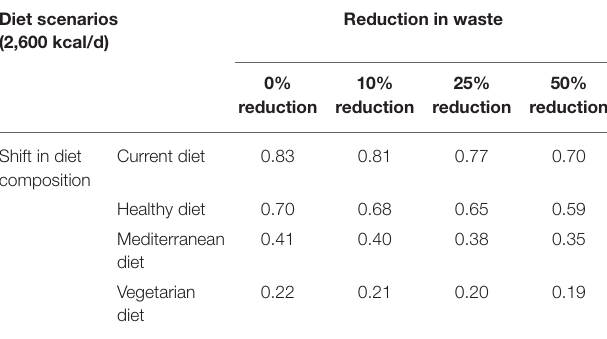
TABLE 3 | Land area (ha) required per person to support the current diet and US Dietary Guideline recommended “Healthy,” “Mediterranean,” and “Vegetarian” diets at three levels of waste